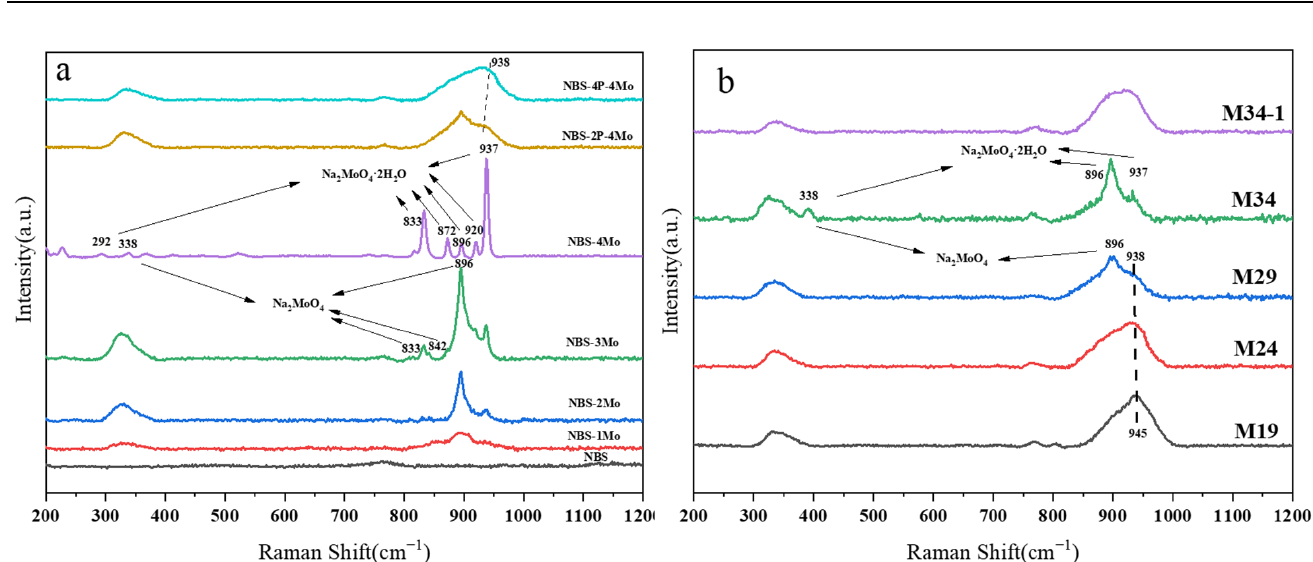
Figure 2. Raman spectra of ( a ) NBS-xMo and NBS-yP-4Mo series and ( b ) Mz series. Table 2. Assignments of the bands in the observed Raman